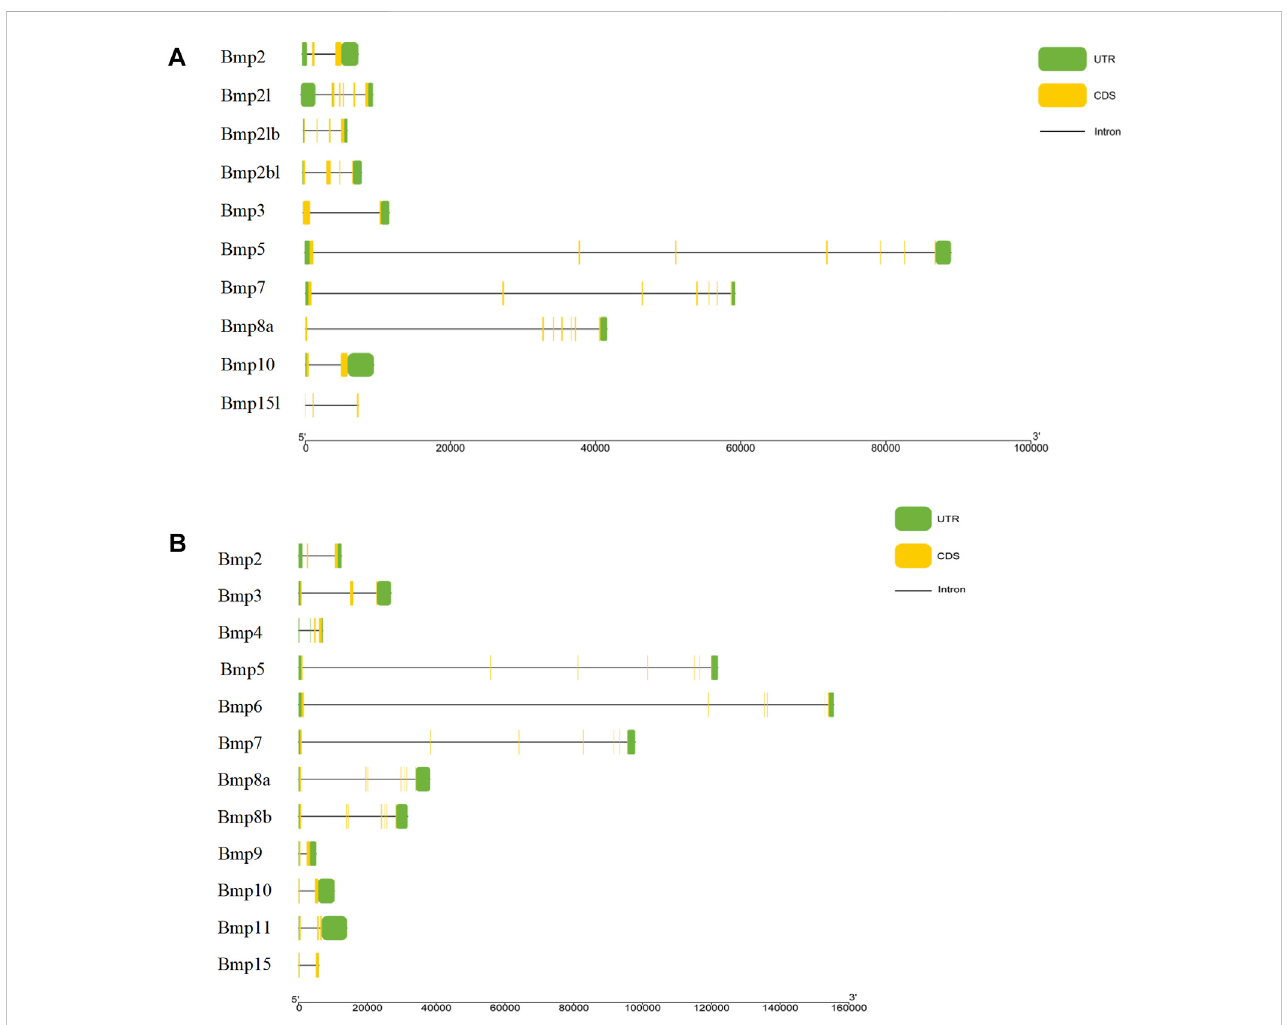
FIGURE 4 Gene structures of BMP genes. (A) . Gene structures of BMP genes in P . sinensis . (B) . Gene structures of BMP genes in Homo. The green boxes show untranslated regions, the yellow boxes show coding sequences, and the black lines show introns.